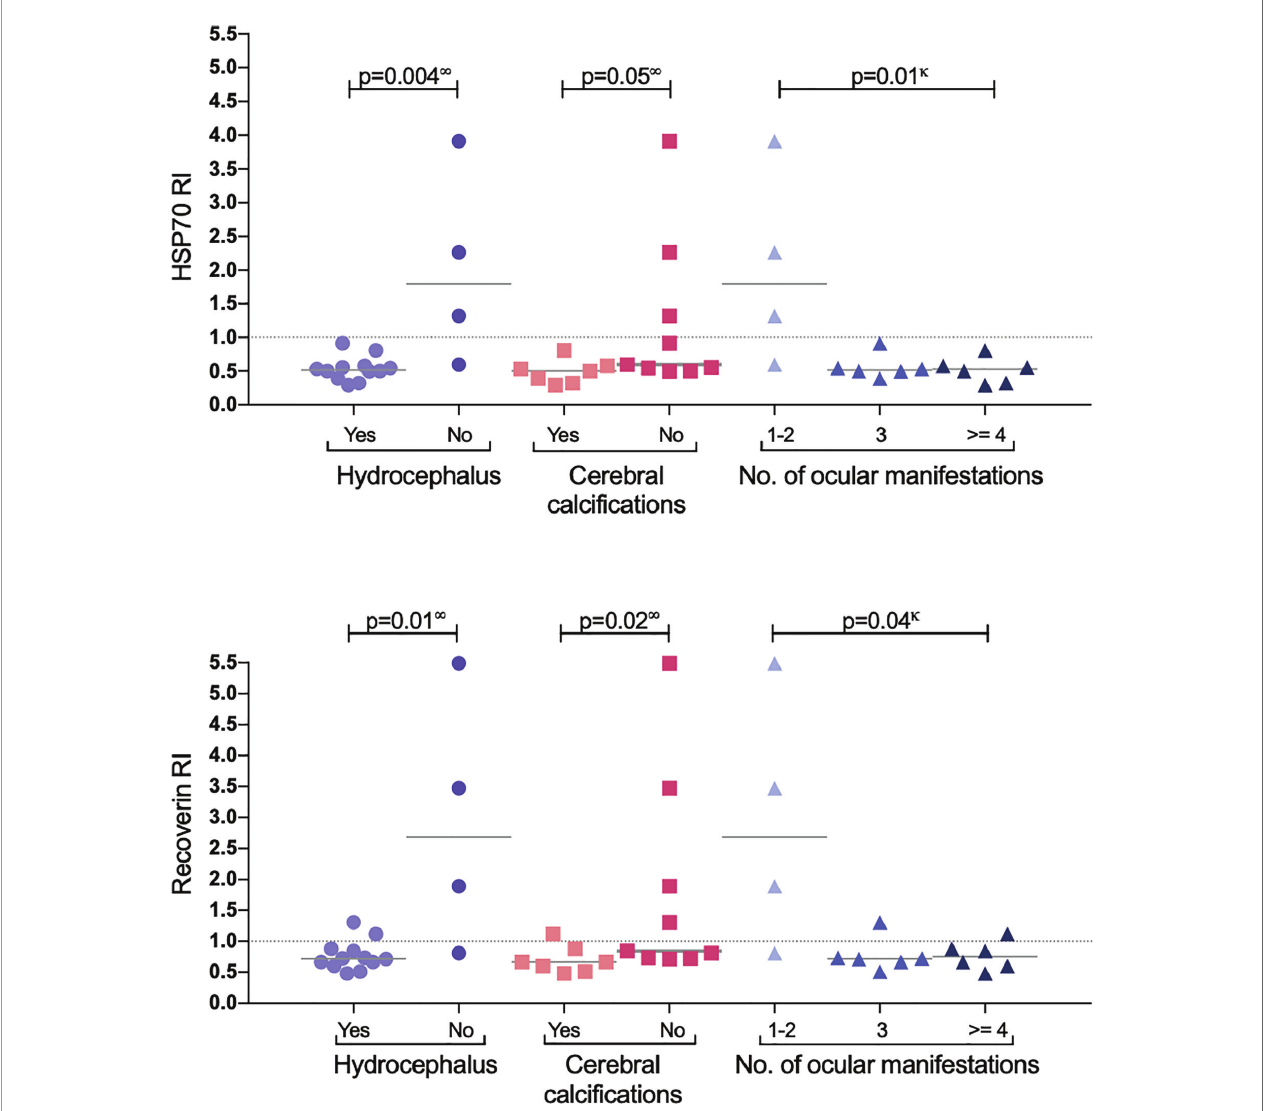
FIGURE 4 | Response to HSP70 (upper graph) and recoverin (lower graph) in the subgroup of neuro-ophthalmic toxoplasmosis. P values using ∞ Mann-Whitney U test, or k